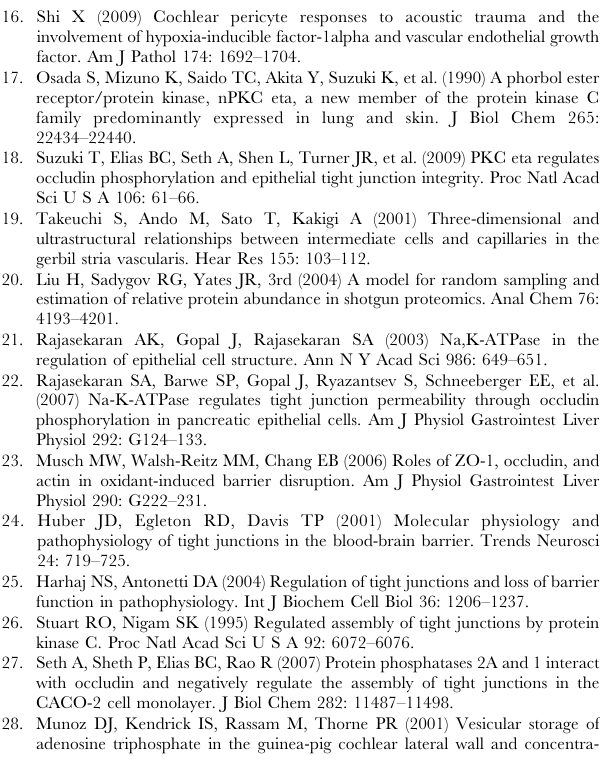
extent of IgG extravasation. A , Capillaries stained with an anti-collagen IV antibody with an arbitrary (a, b) line traced. B , A horizontal threshold is traced, and the vessel diameter (DV) is obtained. C , The same vessel stained with anti-IgG antibody and with the same arbitrary line (a, b) traced. D , The extension of IgG extravasation (EE) has been determined after drawing the background horizontal line. REE is defined as EE subtracted from DV (REE = EE-DV). REE: relative extension of serum protein IgG extravasation; DV: diameter of the vessels; EE: extension of IgG extravasation. (TIF) Figure S2 Isolated capillary protein classification ac- cording to cellular component. A , GO annotation by cellular component. 544 proteins were identified to be associated with a diverse cellular component and mitochondrial proteins, including matrix proteins (17%), inner membrane proteins (16%) and outer membrane proteins (1%), were highly expressed in the blood- labyrinth barrier. B , Allocation of isolated stria vascularis capillary proteins by cellular component showed the greatest number of these proteins (95) were allocated to a mitochondrial matrix. Figure S3 Isolated capillary protein classification ac- cording to molecular function. A , GO annotation by molecular function. 526 proteins were identified to be related to molecular functions and proteins involved in catalytic activity (31%) were highly expressed in the blood-labyrinth barrier. B , Allocation of isolated stria vascularis capillary proteins by molecular function showed that the greatest number of these proteins (164) was allocated to catalytic activity and the smallest (1) to electron carrier activity. (TIF)